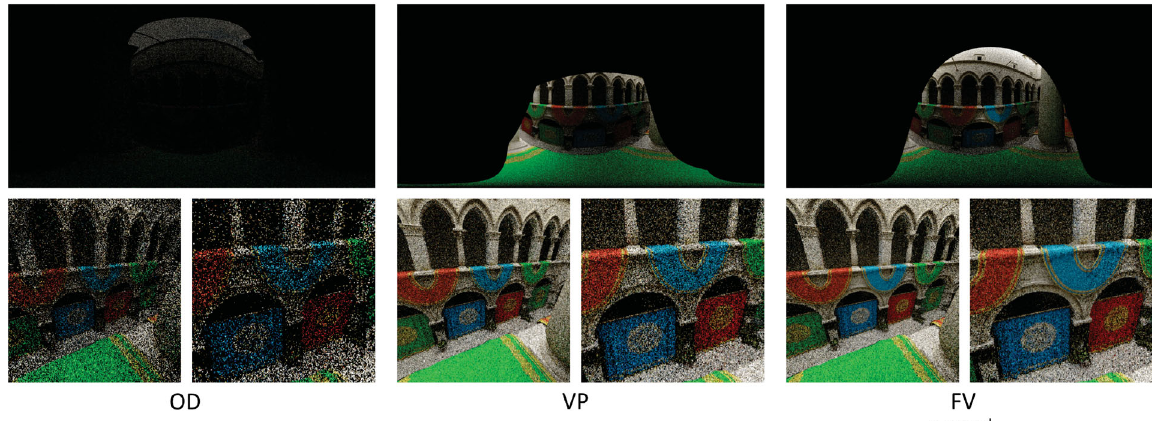
Fig. 1 Results after two seconds of rendering with a static point of interest. Above: rendering buffer. Below: preview on screen, and close-up of the point of interest. Note how it already starts to converge in our proposed foveated preview approach (FV) which uses eye tracking and a human visual acuity model. On the other hand, the edges in FV are noisier than when uniformly sampling the viewport area (VP). Uniform sampling of the whole 360 ◦ image (OD) is noisier than the other